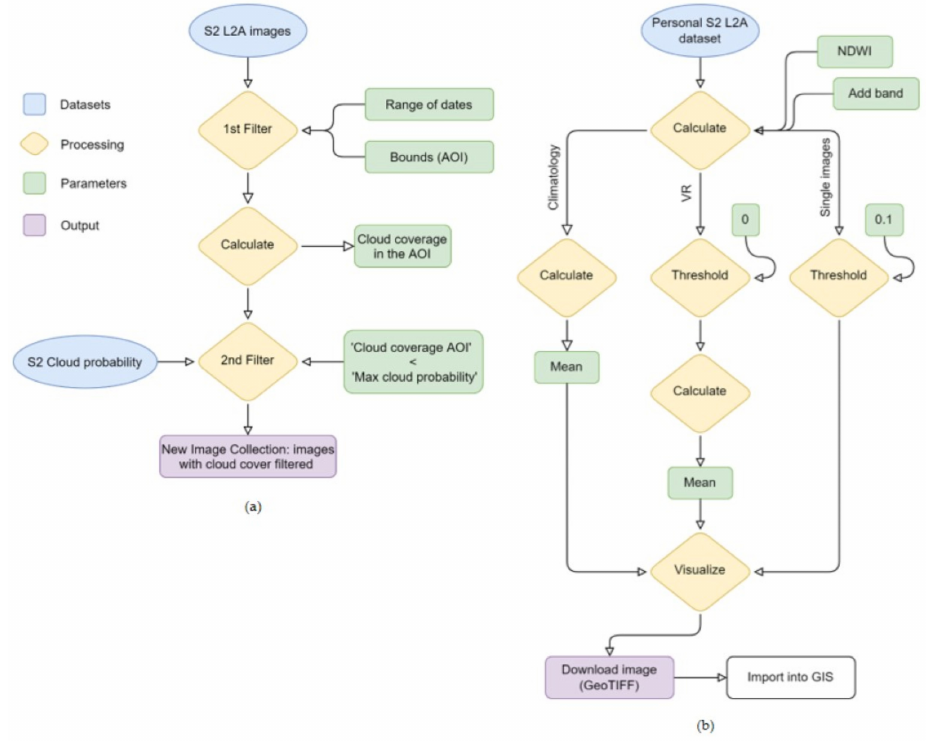
Figure 4. Geoprocessing workflow in GEE with S2 L2A images. ( a ) low cloud cover probability image selection workflow; ( b ) NDWI index application and statistical geoprocessing workflow (climatology and